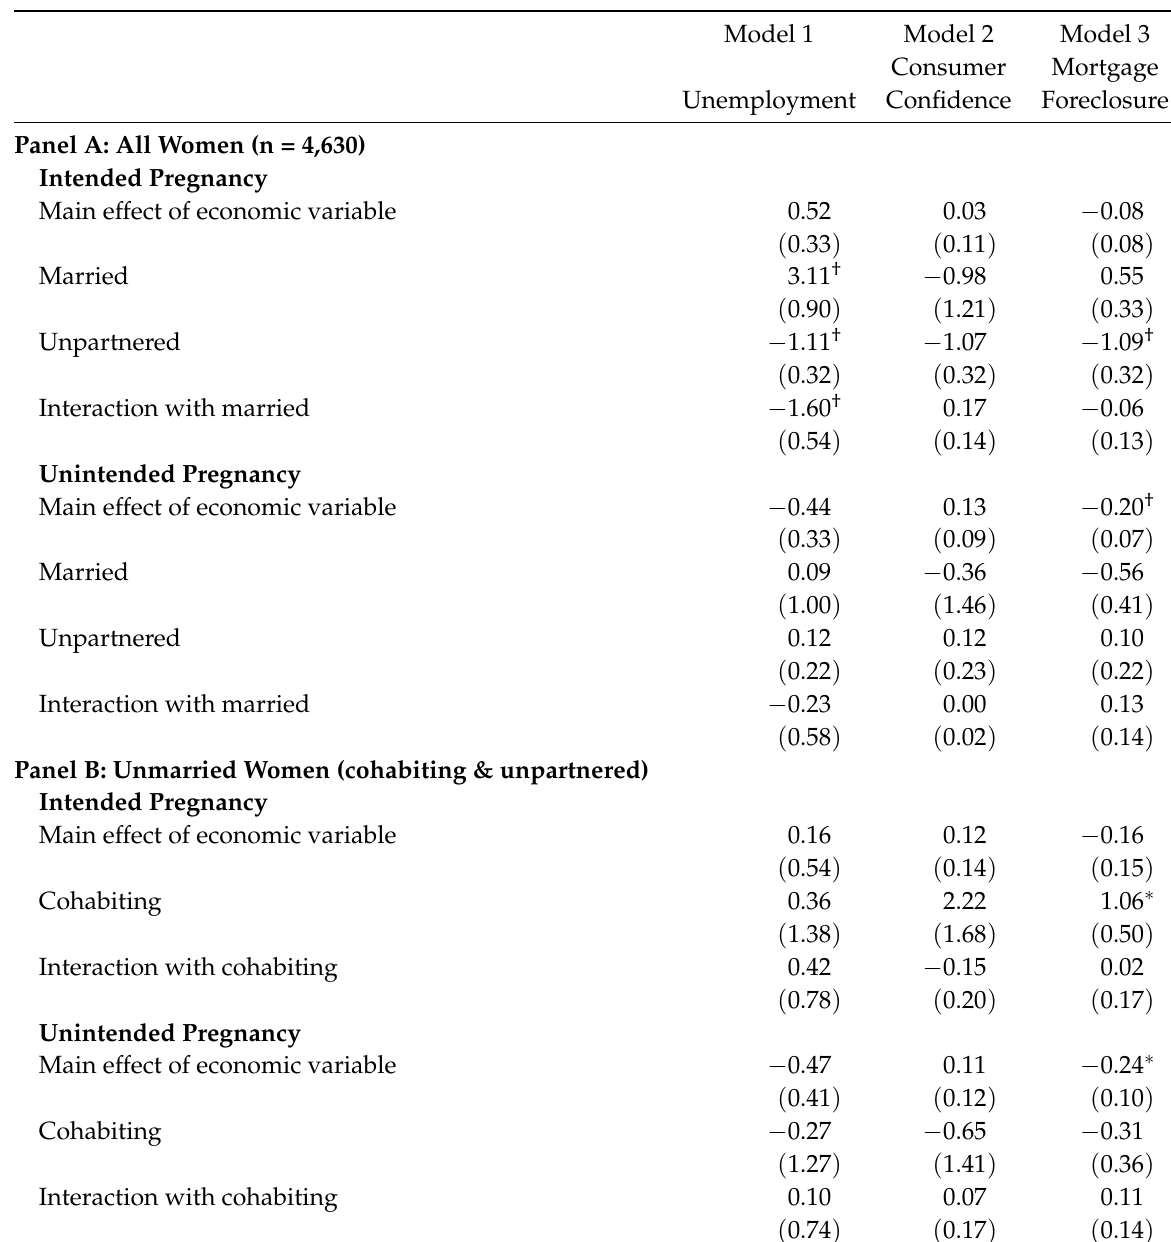
Table 4: Coefficients from mlogit models predicting intended and unintended pregnancy relative to no pregnancy by state-level economic conditions with interactions for partnership or marital